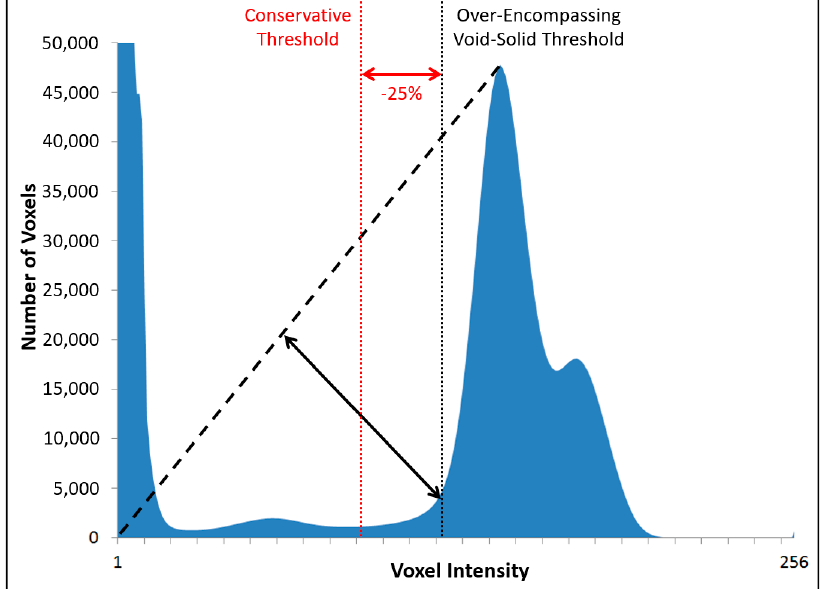
Figure 4. Automated threshold selection using the triangle approach (based on figure in [10]).